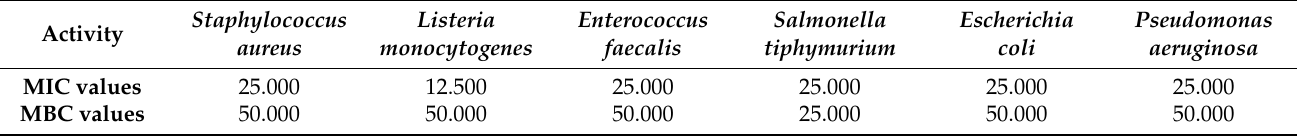
Table 3. Results of the antibacterial activity tests on the 2017 EO of Cinnamomum camphora .